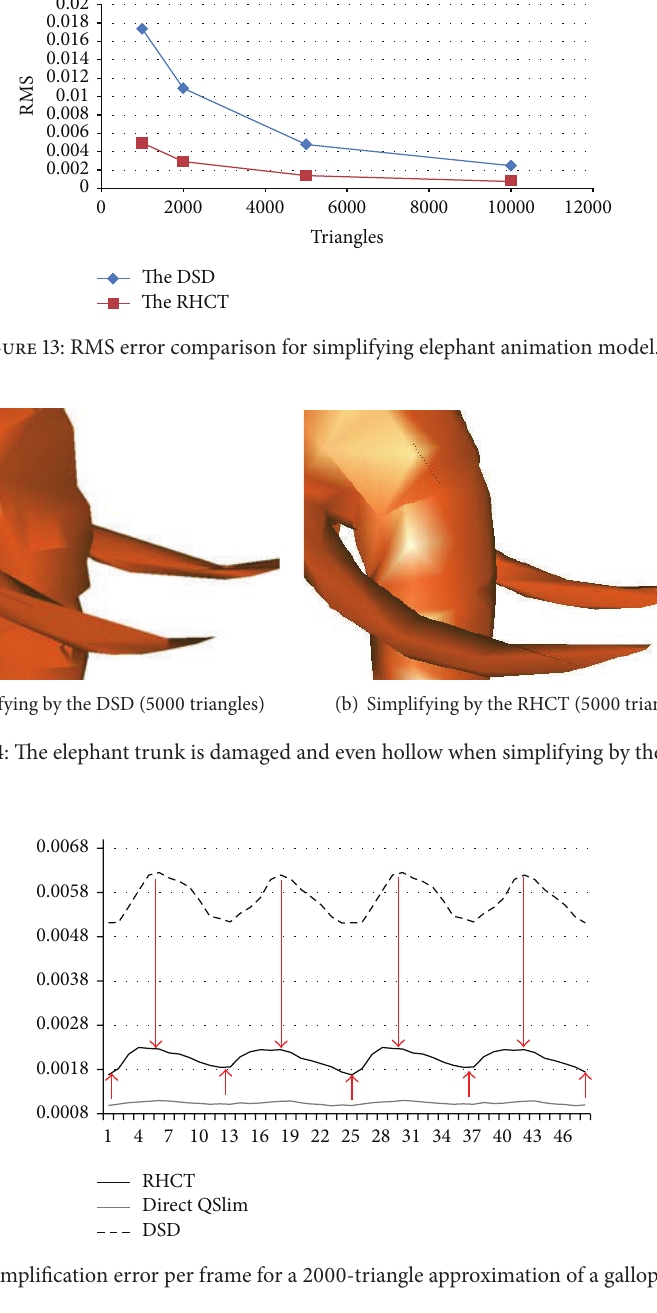
to 5000 triangles and used TPDM and MSDM2 to measure the perception distortion, as shown in Tables 4 and 5 and Figure